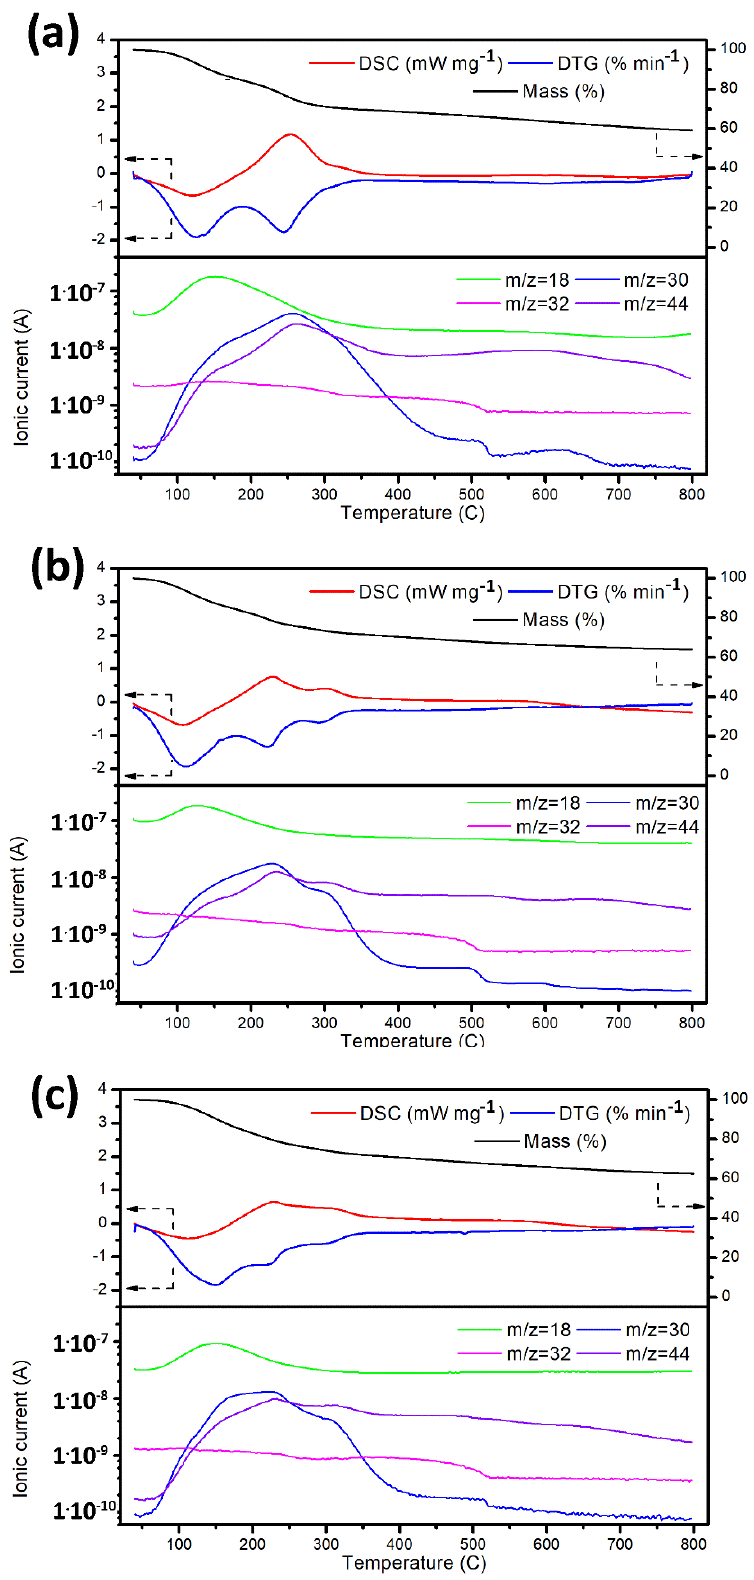
Figure 4. TG, DTG, and DSC curves (top) and gas products (bottom) of La/GNFs_ox ( a ), Nd/GNFs_ox ( b ), and Gd/GNFs_ox ( c ) heat treatments under Ar atmosphere.